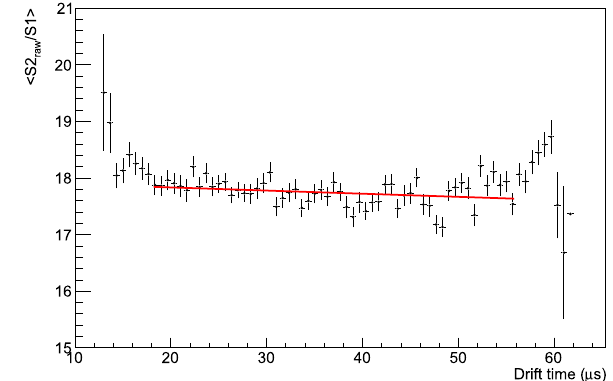
Fig. 12 (cid:5) S2 ra w /S1 (cid:6) vs. drift time for an 241 Am calibration run with = 183 V/cm, together with the best fit according to the parameteri- E d sation given in Eq.